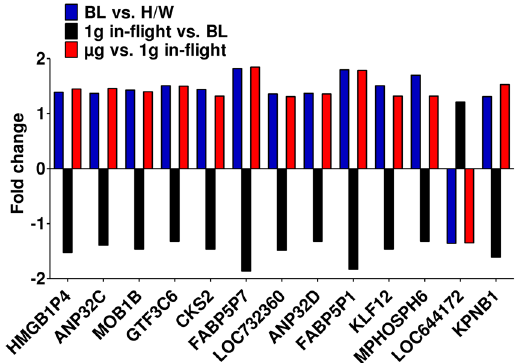
Figure 9. Gravity-responsive gene expression (suborbital rocket flight). Expression level fold changes of genes in Jurkat T cells that are exclusively altered during rocket launch (BL) when compared to the hardware ground control (H/W), and microgravity ( µ g) when compared to the 1 g in-flight control during the TEXUS-51 campaign (log2 values, p <